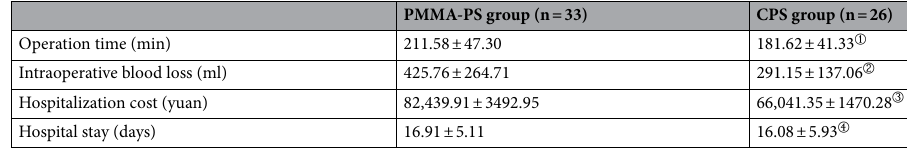
Table 2. Surgery-related information for both groups of patients. ①②③ Compared with PMMA-PS group, P < 0.05. ④ Compared with PMMA-PS group, P > 0.05.